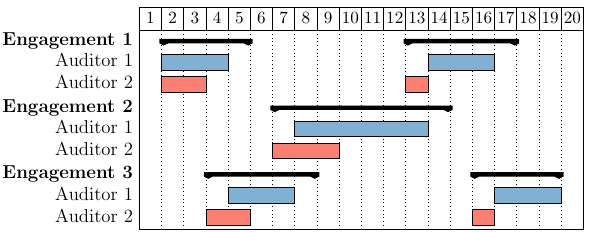
Fig. 1 An example of a schedule for two auditors and three engagements. Engagements can be divided into phases, for exam- ple, interim and final in engagements 1 and 3. The engagement availability window is depicted within black